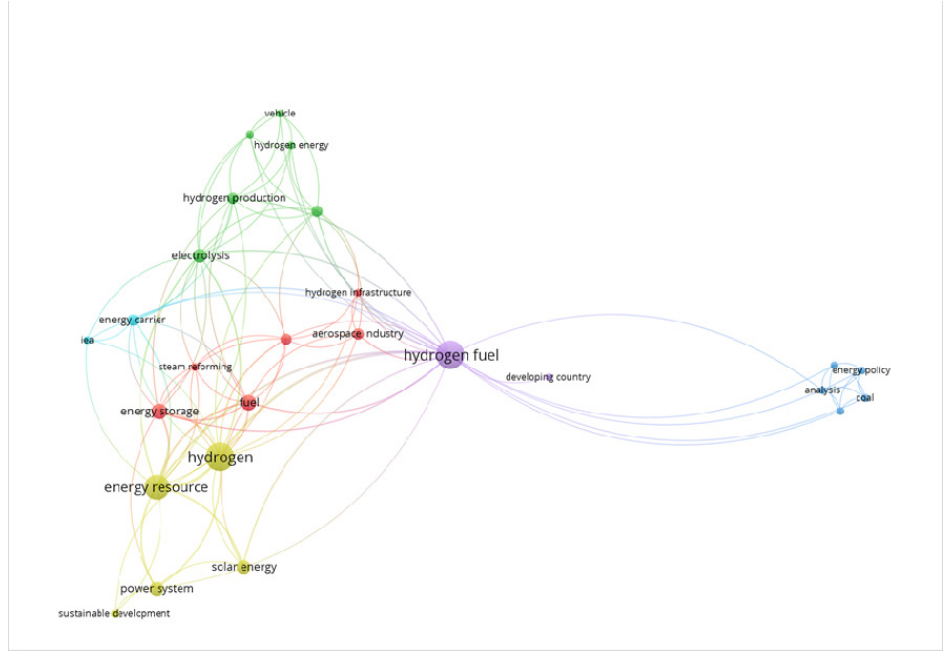
Figure 3. Keyword network map for 1980 to 1989.